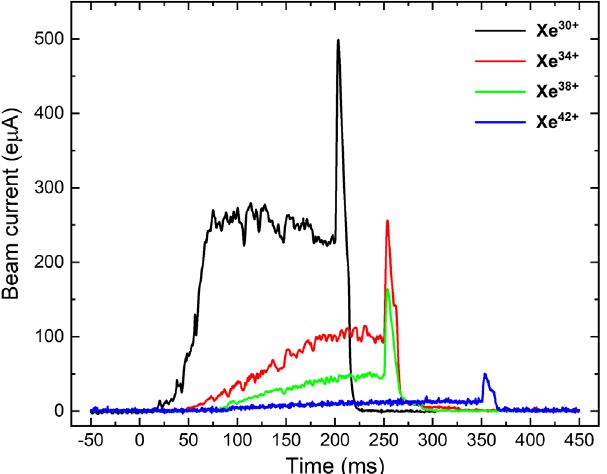
FIG. 9. Xenon charge state distributions for cw mode and afterglow mode optimized on Xe 34 þ , in this figure, Xe 32 þ overlaps with O 4 þ and Xe 40 þ with O 5 þ . To illustrate a clearer variation trend of beam intensity, Xe 40 þ is not shown in this figure. In addition, the gain factor of beam intensity in afterglow mode compared to cw mode is presented.